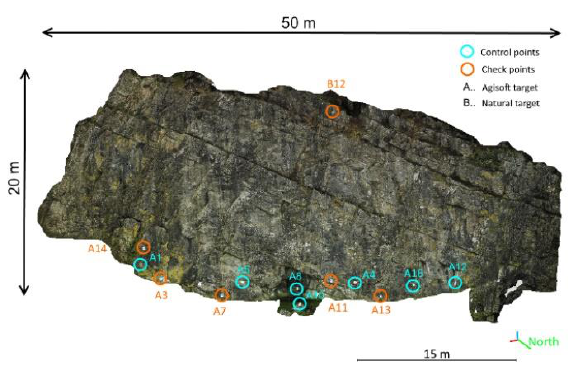
Figure 7. Saulges dense point cloud (check and control points) During the UAV acquisition session, a rough manual in-situ structural survey was carried out. Three families were detected.